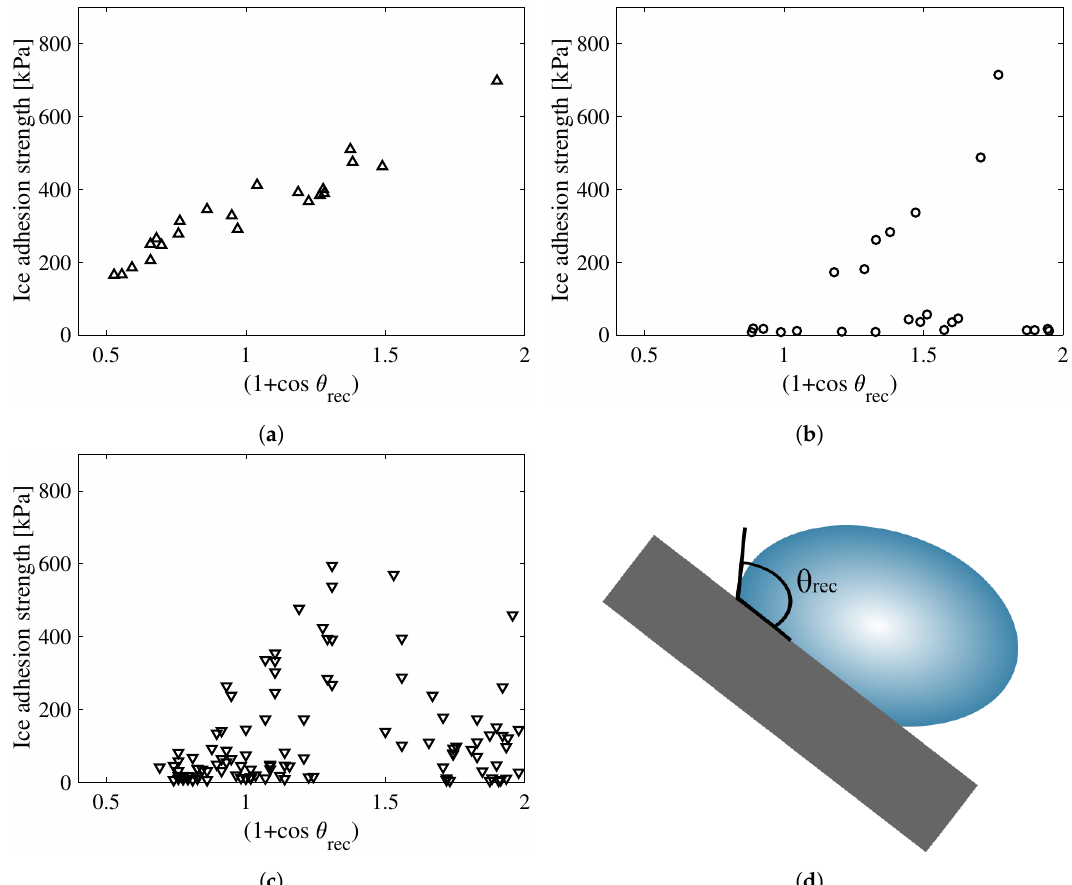
Figure 3. Experimental results on the relation between receding contact angle and ice adhesion strength for a collection of surfaces; ( a ) Results from Meuler et al. [22], with 22 samples. Adapted with permission [22], 2010 American Chemical Society; ( b ) Results from He et al. [18], with 24